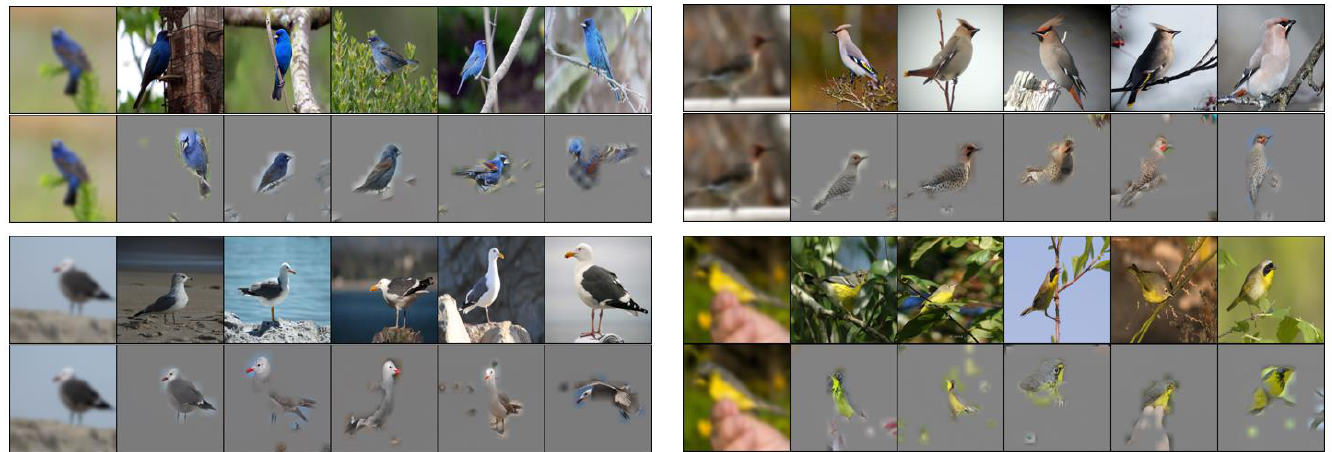
Figure 7. Top 5 retrieval results of samples from the CUB200-2011 dataset. The first image on each row is the query image. The figure shows comparisons between using attention embeddings (the second row) and without attention (the first row).